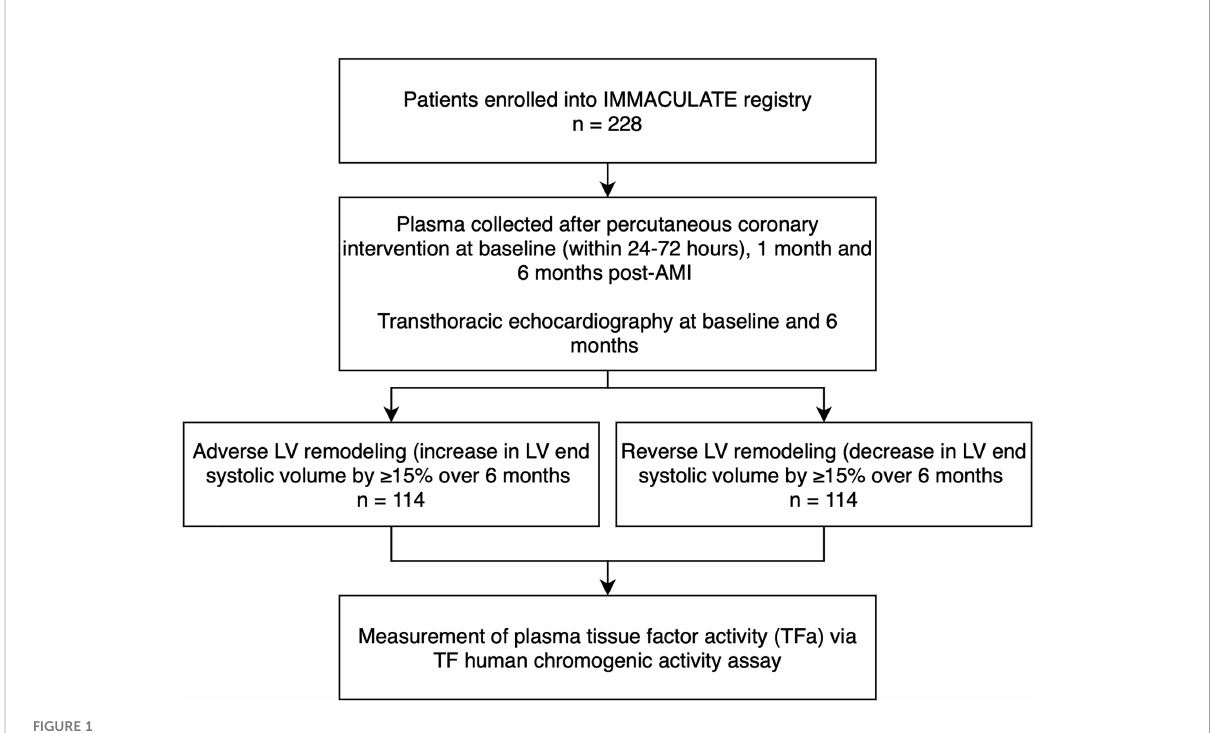
FIGURE 1 Study design fl